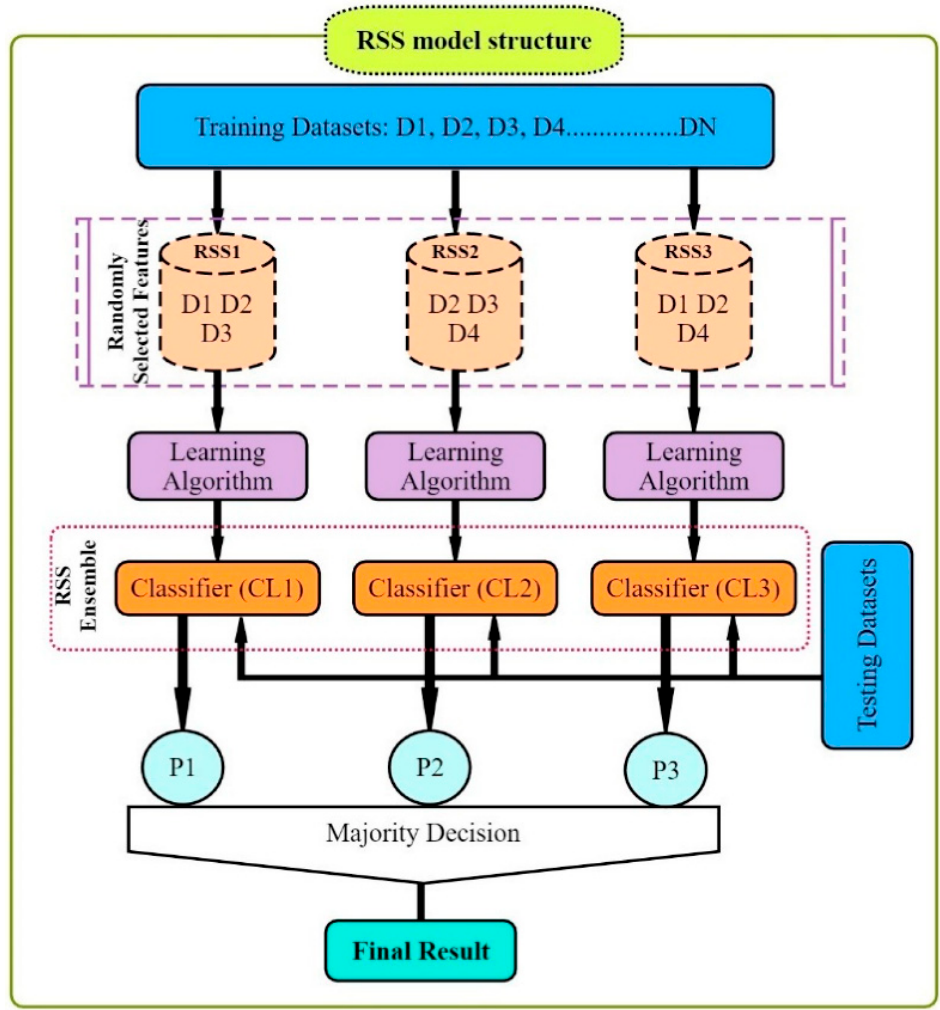
Figure 4. The block diagram of the random subspace.